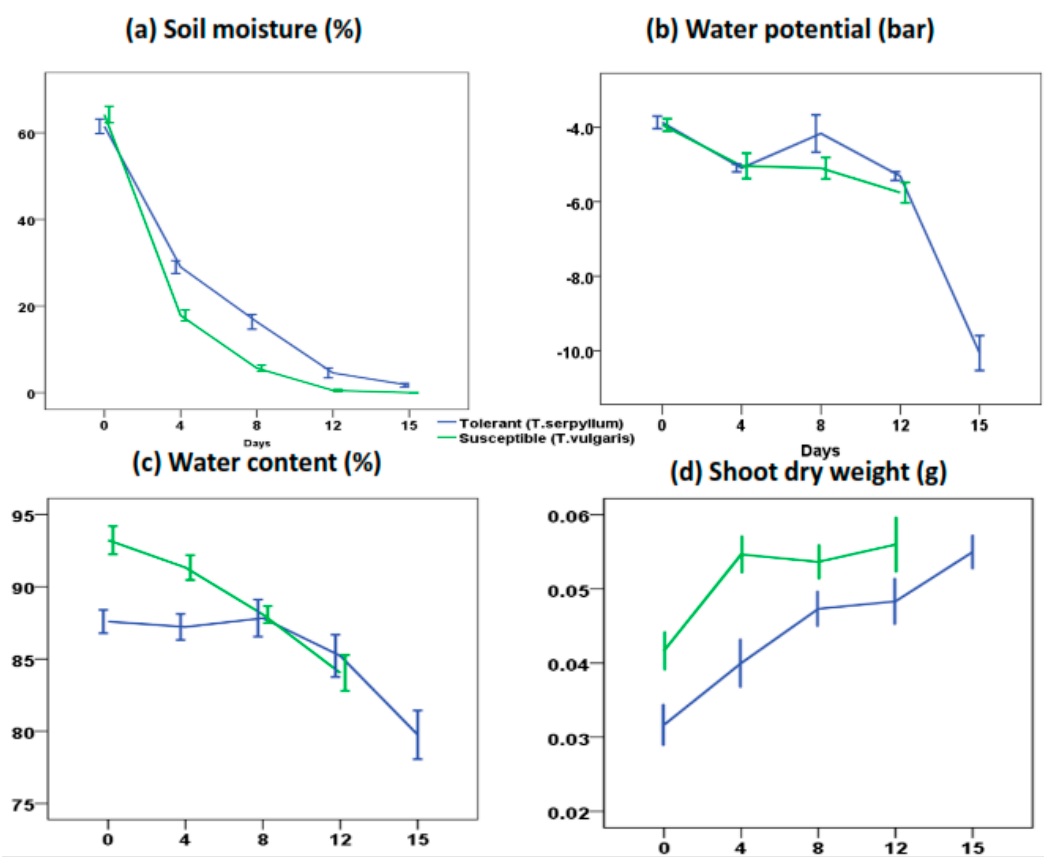
Figure 1. Impact of drought stress on physiological parameters in tolerant and sensitive thyme [15]: ( a ) soil moisture (%); ( b ) water potential (bar); ( c ) water content (%); and ( d ) shoot dry weight (g). Drought stress was imposed by water withholding on one-month-old plants of tolerant and sensitive populations ( Thymus serpyllum and Thymus vulgaris , respectively). Physiological parameters were recorded at 4-day intervals.